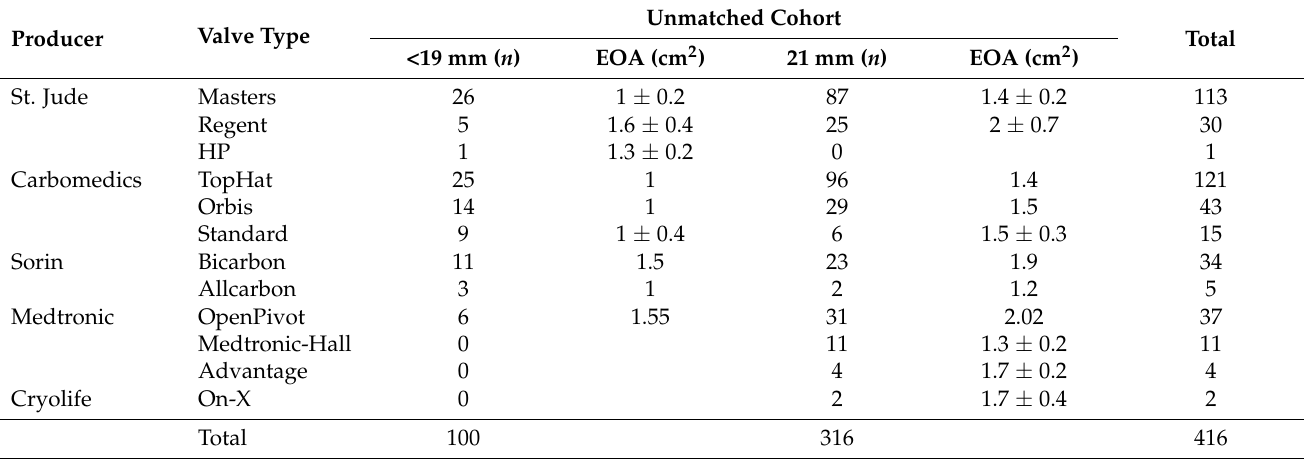
Table 2. Types of prostheses implanted in the unmatched